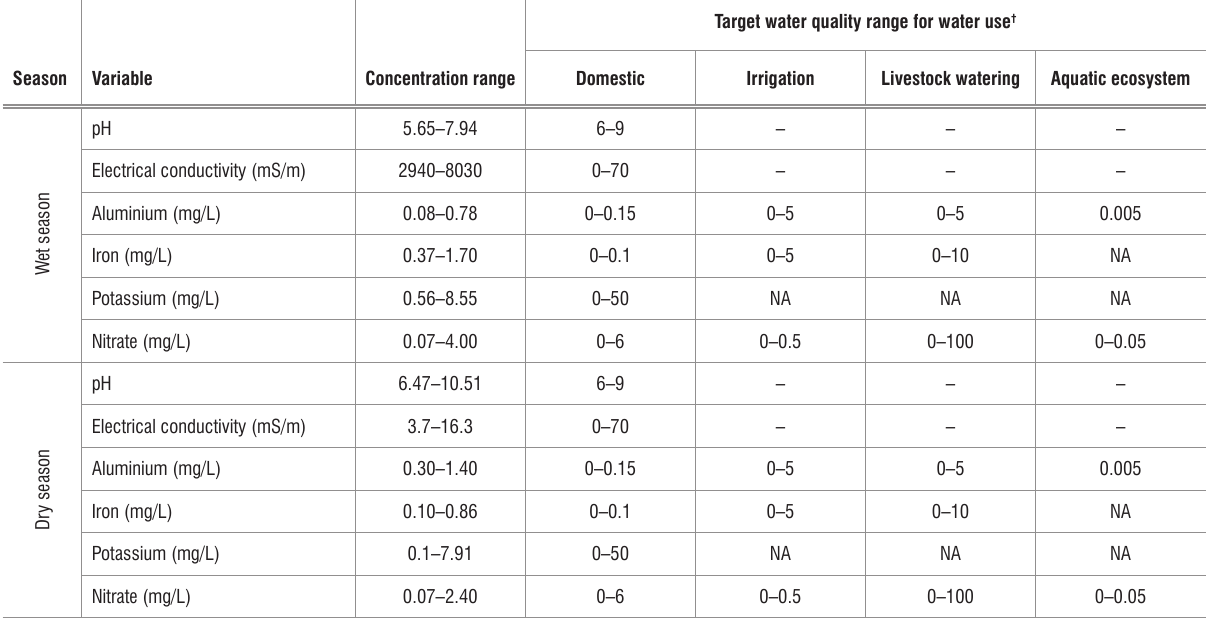
Concentrations of elements, pH and electrical conductivity of water from Bonsma Dam